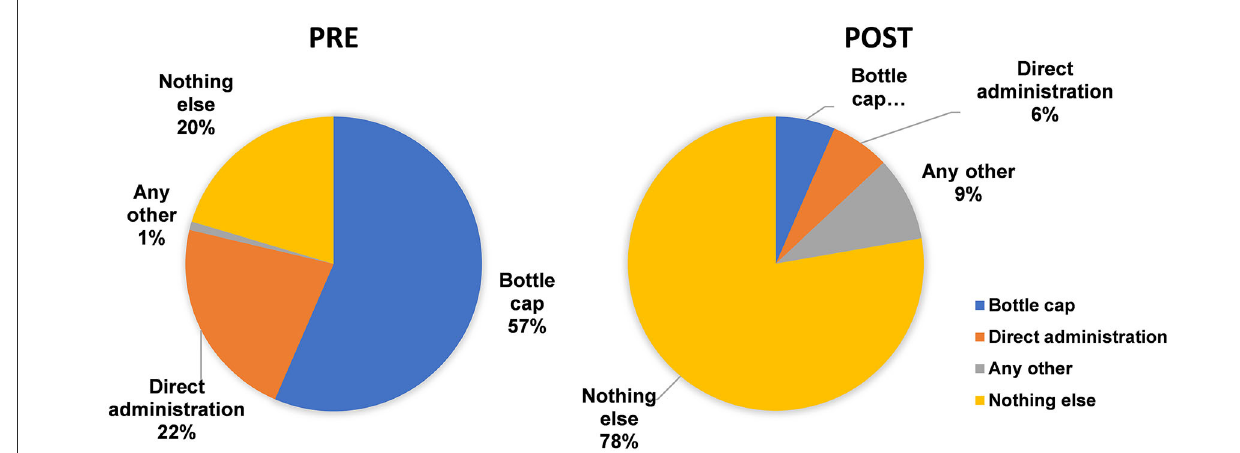
FIGURE8 Three best choices for oral medicine administration aids (pre- and post-test).